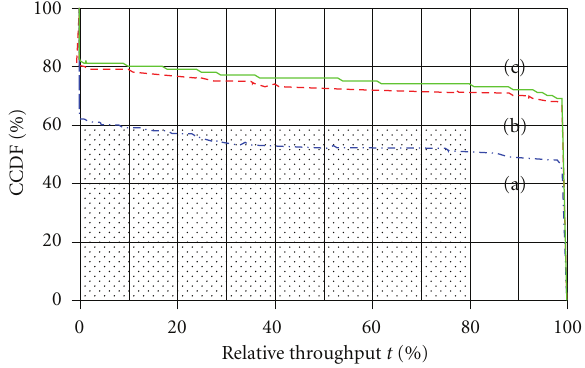
Figure 7: Measured CCDFs of throughput for a Band 7 dongle with external antennas: (a) collinear dipoles arrangement (blue), (b) cross-polarized dipoles setup (red), and (c) 45 ◦ polarization inclination (green) at RS EPRE = − 100 dBm/15kHz. The shaded region indicates a possible rejection criterion (see